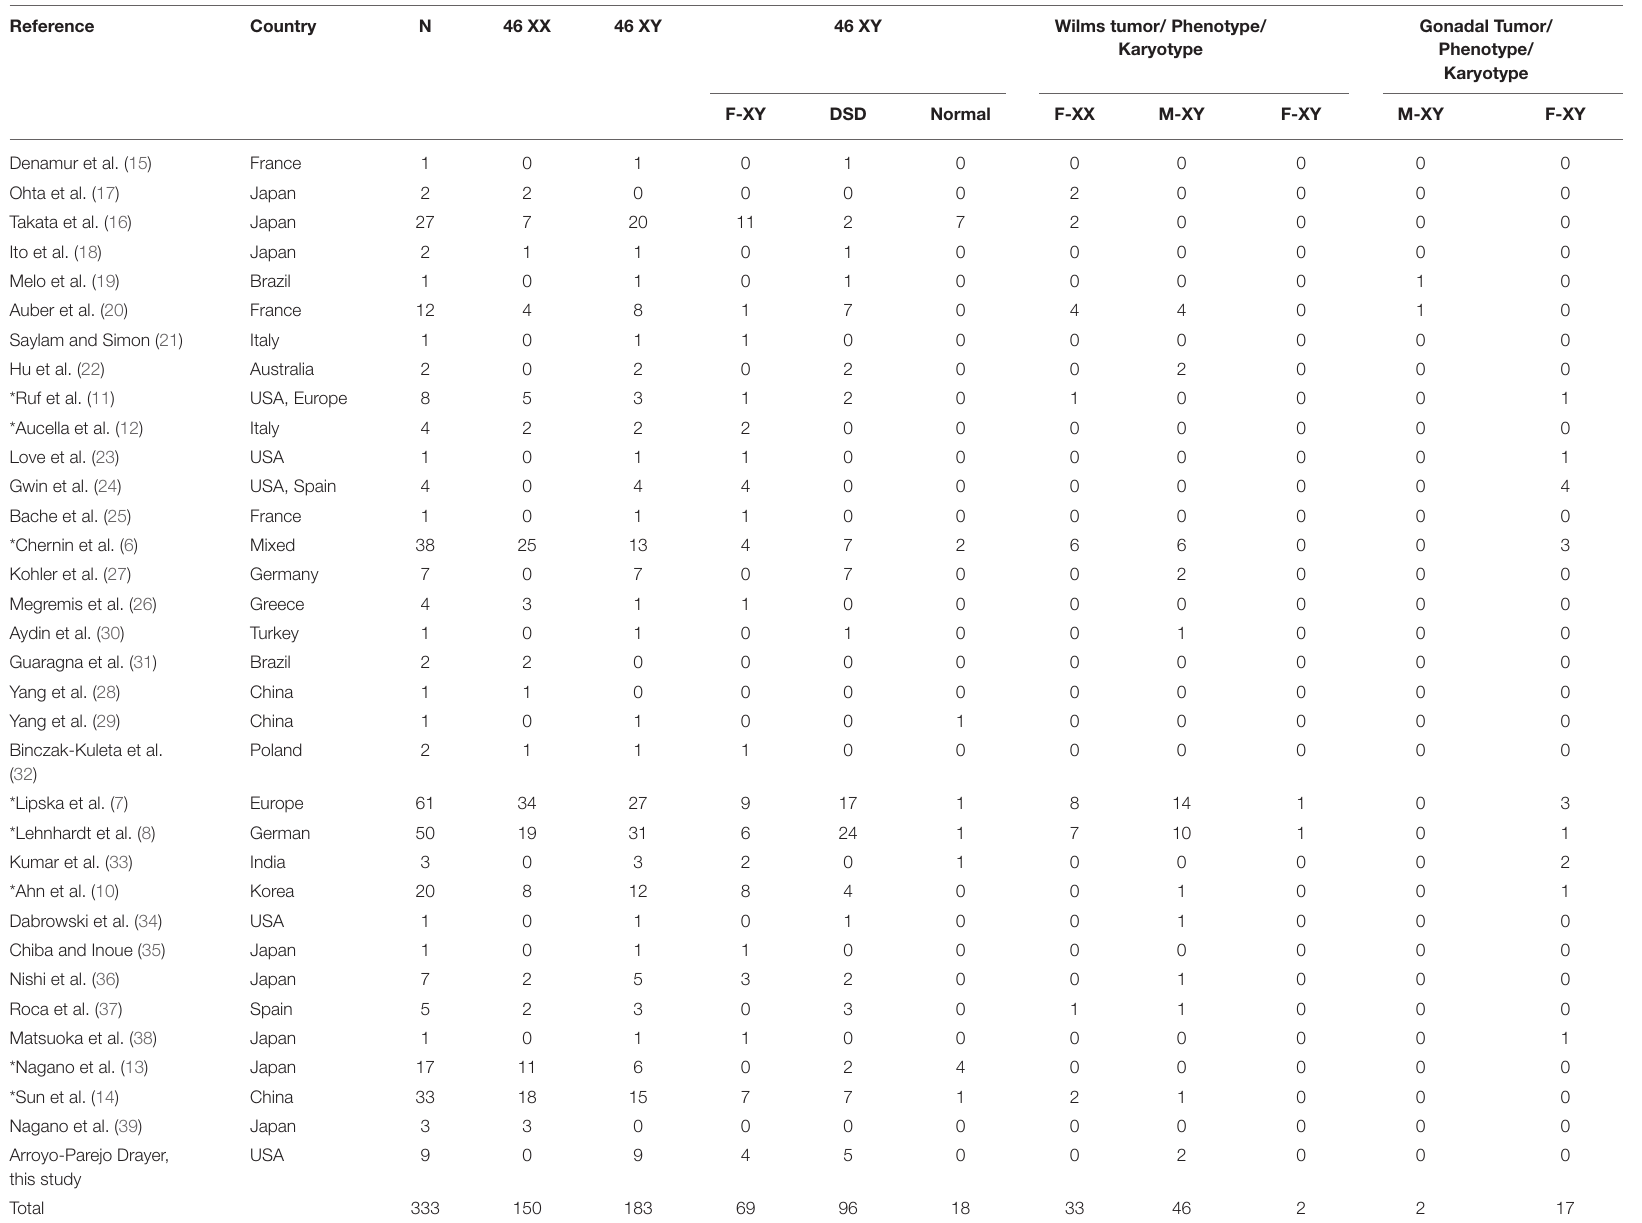
TABLE 3 | Karyotype–phenotype and associated Wilms and gonadal tumors in WT1